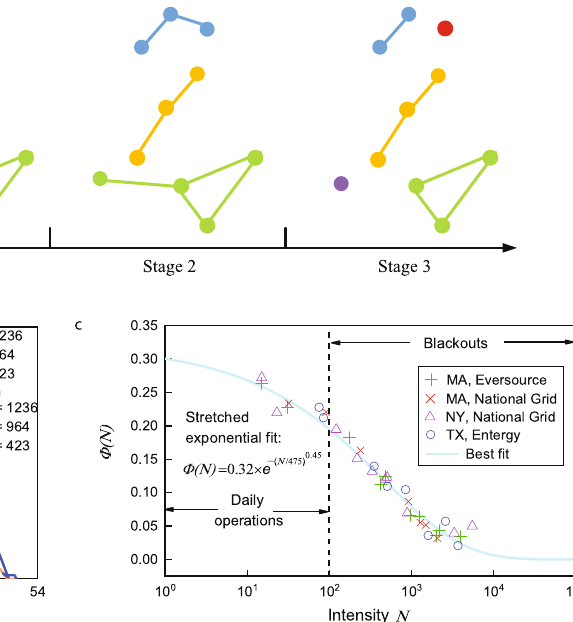
clusters as shown by the dashed red and orange lines. If the red line is adopted, the initial cluster breaks three links and fragments into a 6-node blue cluster and a 4-node green cluster. With recursive frag- mentation, fi ve clusters occur on stage 3 with two of them (red and purple dots) containing only one node.